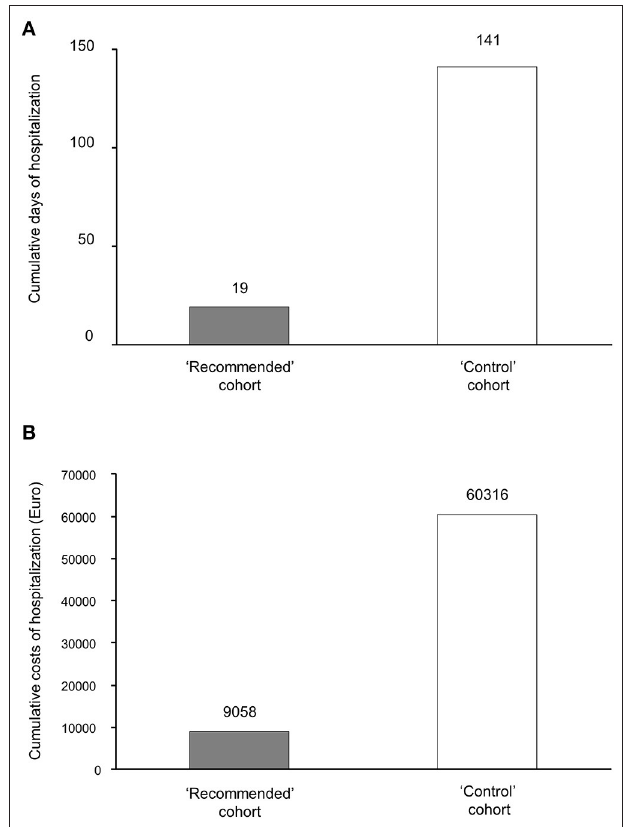
FIGURE 2 | Cumulative length of hospital stays and related costs in the two study cohorts. Cumulative days of hospitalization (A) and cumulative costs for hospital stays (B) in the “recommended” treatment cohort and in the “control” cohort. Gray columns, “recommended” treatment cohort; white columns, “control